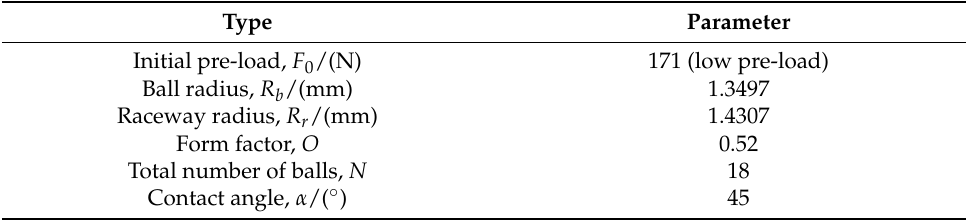
Table 1. Main parameters of LRG.